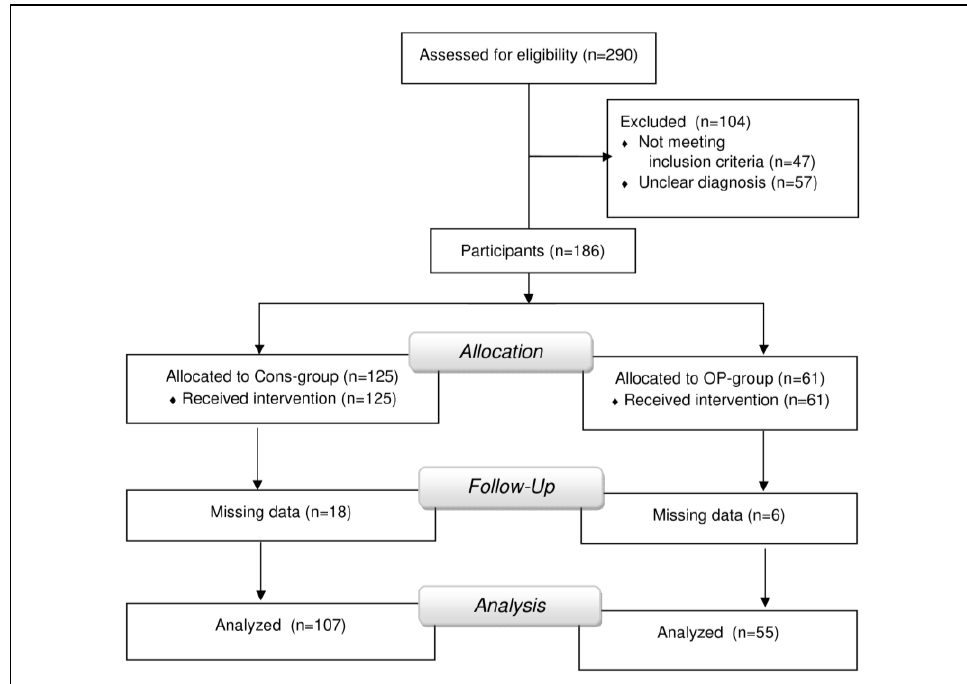
Figure 1. Flow chart illustrating the participant recruitment